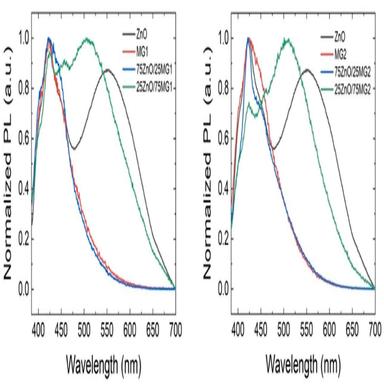
PL spectra of the synthesized materials.